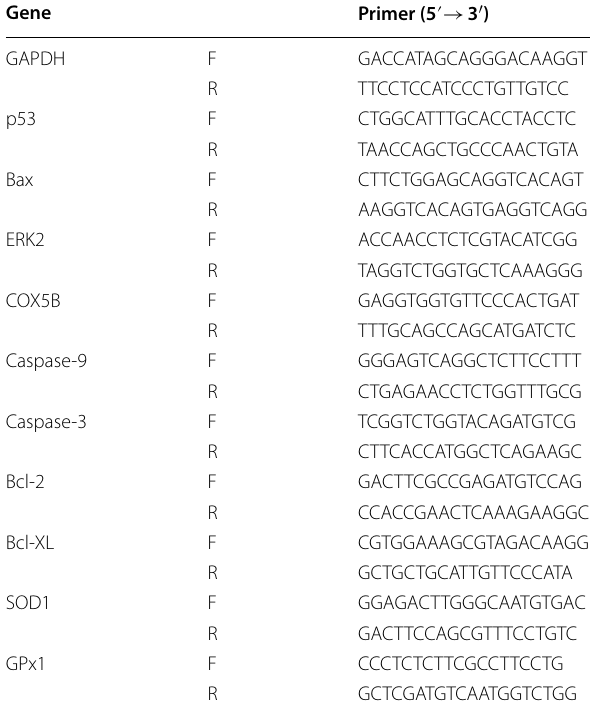
Table 2 The primer sequences for